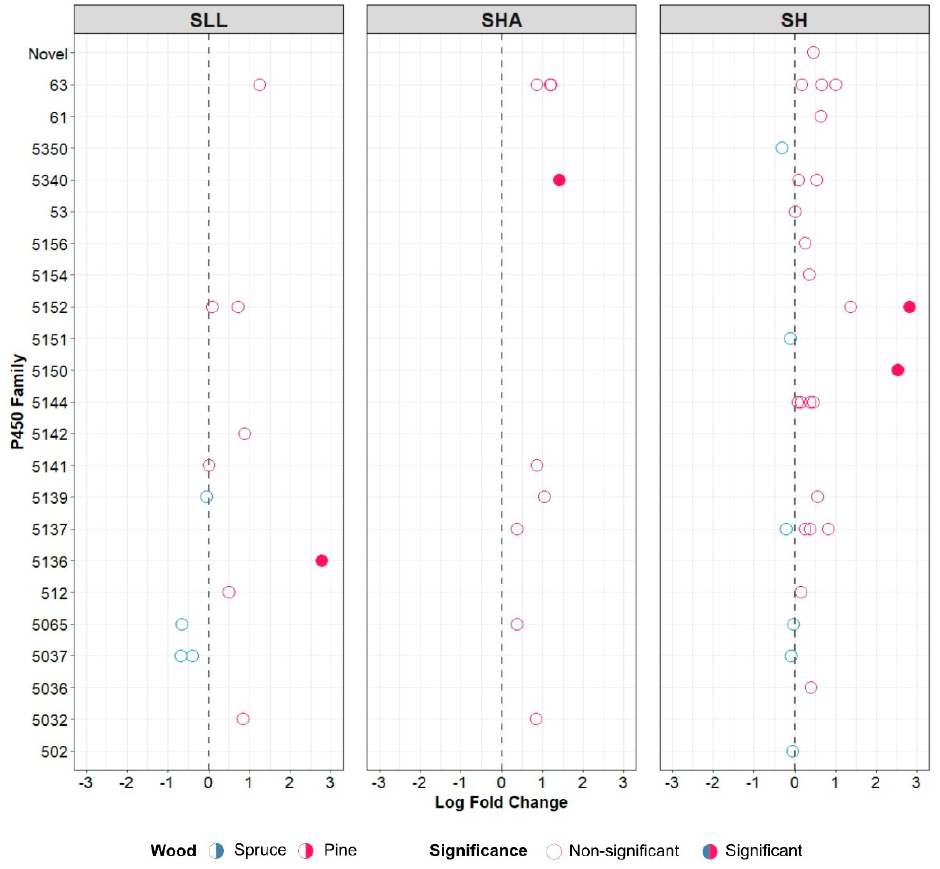
Figure 6. Pine-specific and spruce-specific P450 transcripts for S. lacrymans var. lacrymans (SLL), S. lacrymans var. shastensis (SHA) and S. himantioides (SH). Predicted P450 families with transcripts differentially up-regulated between growth on media supplemented with pine or spruce are included. A log fold change < 0 was related to expression on media supplemented with spruce, and a log fold change > 0 to media supplemented with pine. Solid points indicate families with significant differential expression between the wood-supplemented media types ( p ≤